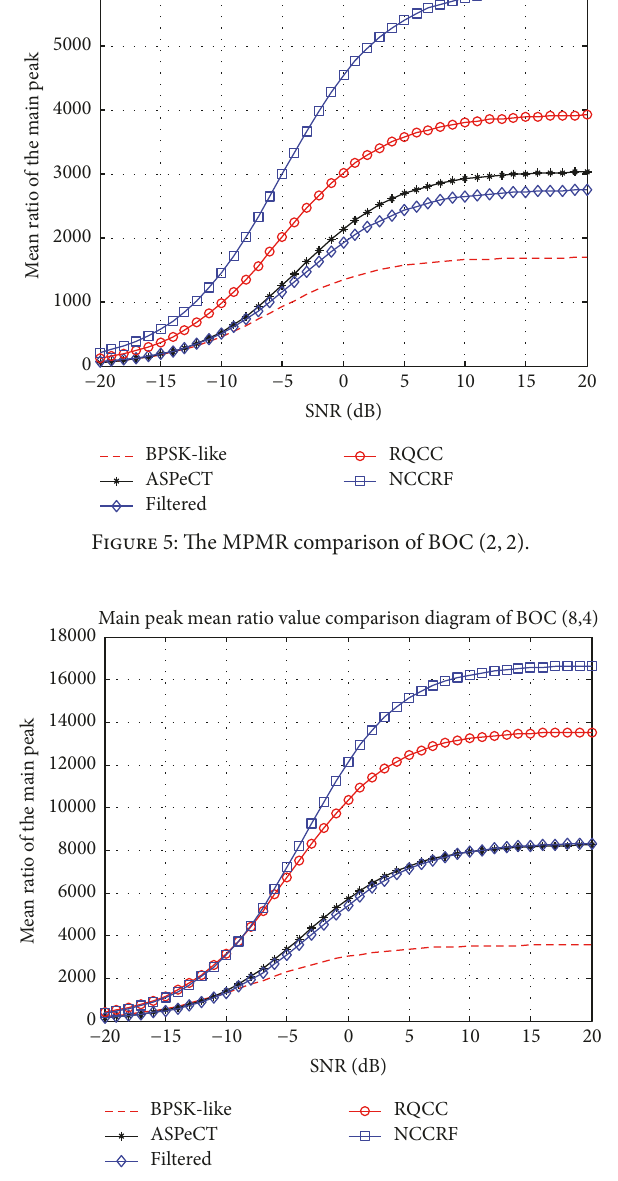
Figure 6: The MPMR comparison of BOC ( 8,4 ).